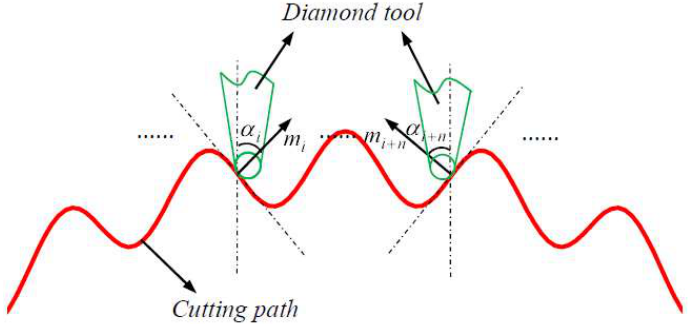
Figure 13. Illustration of wrap angle optimization.